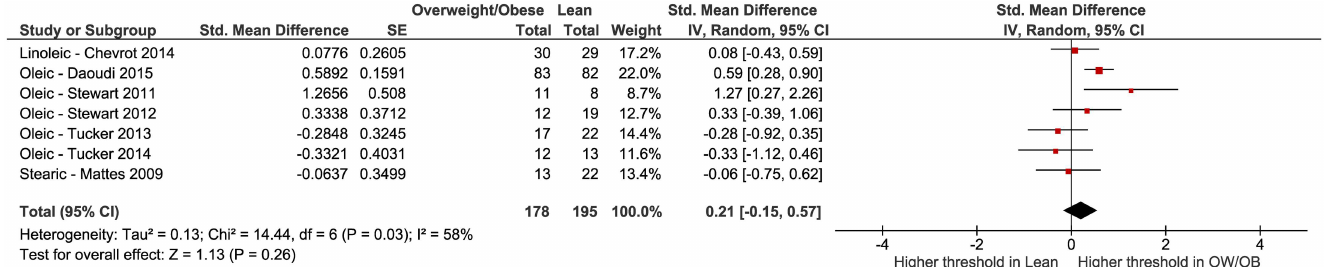
Fig 3. Forest plot of fatty acid taste thresholds of long-chain fatty acids of groups of participants who were lean versus overweight or obese [6–8,10,14,16,26].